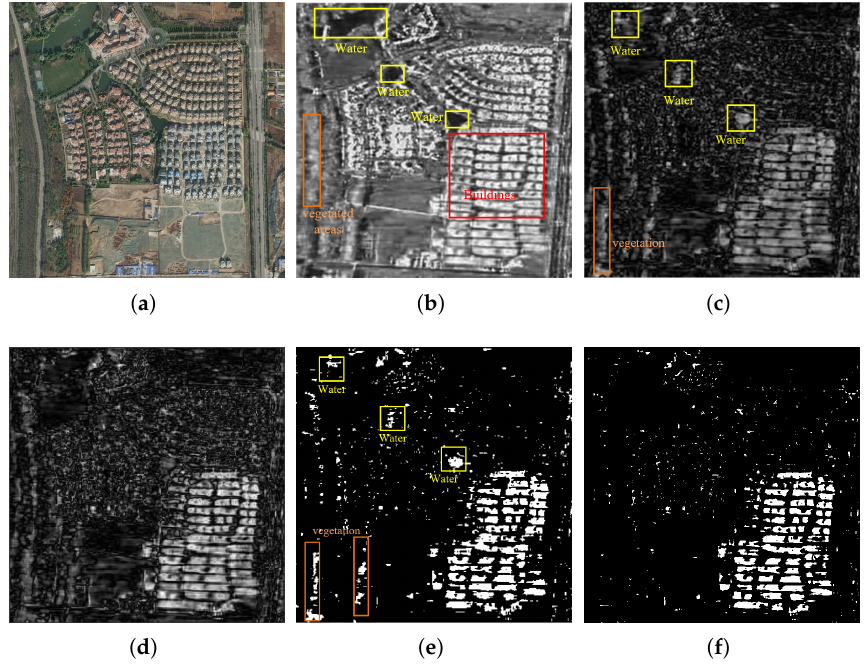
Figure A1. The comparison between optical and SAR image, as well as the comparison between log-ratio map and image differencing map. ( a ) optical image cropped from Google Earth; ( b ) SAR images. ( c ) log-ratio map. ( d ) image differencing map. ( e ) HFEM thresholding result of log-ratio map. ( f ) HFEM thresholding result of image differencing